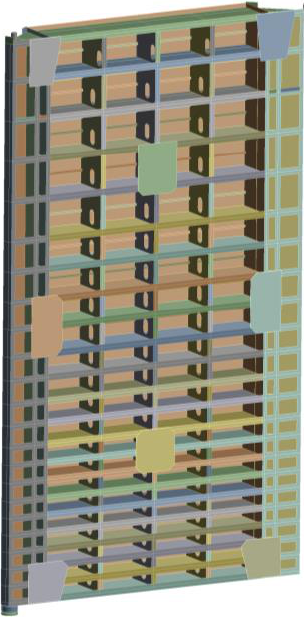
Figure 5. Three-dimensional solid model of gate Pro E.